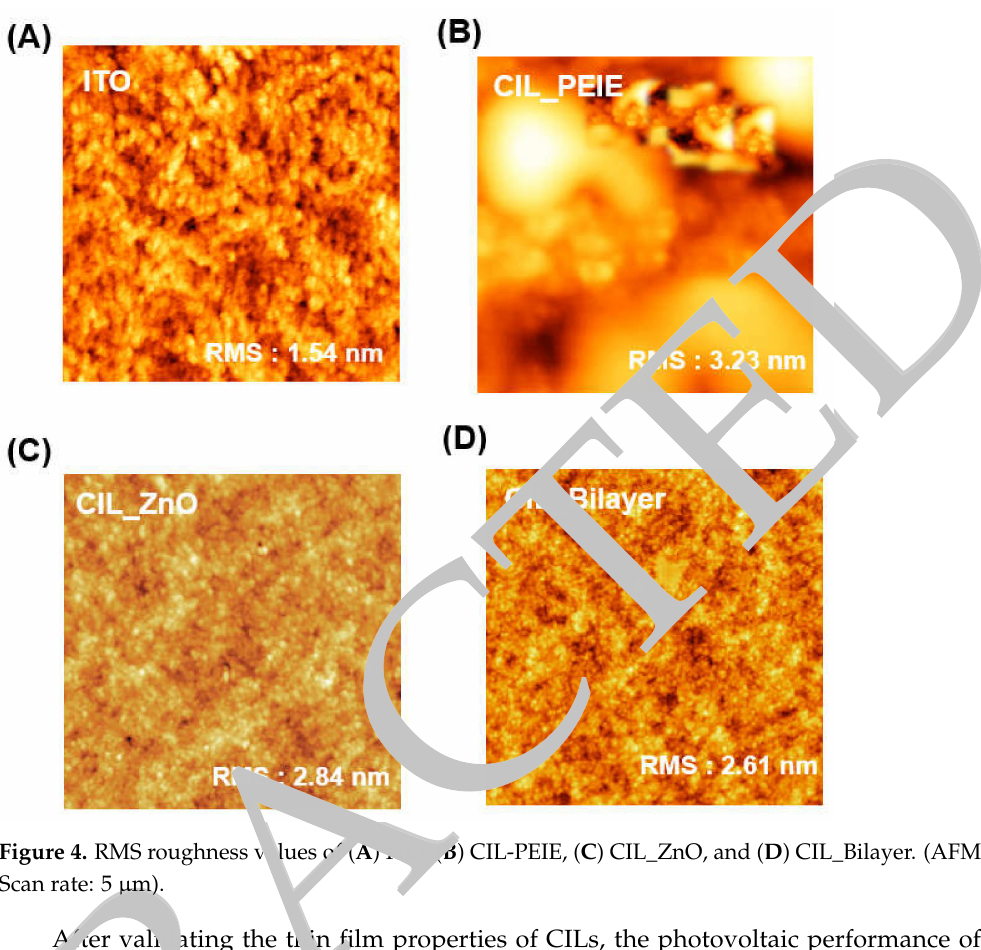
Figure 4. RMS roughness values of ( A ) ITO, ( B ) CIL-PEIE, ( C ) CIL_ZnO, and ( D ) CIL_Bilayer. (AFM Scan rate: 5 µ